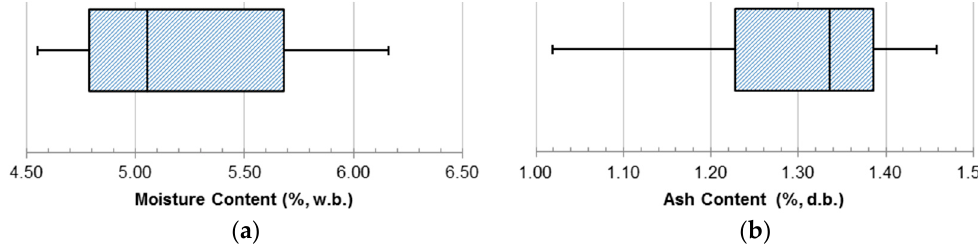
Figure 7. The distribution of measured values for ( a ) wet-basis moisture content; and ( b ) dry-basis ash content of the micronized charcoal particles. The box-and-whisker plot represents the minimum, first quartile, median, third quartile, and maximum values from left to right, respectively.